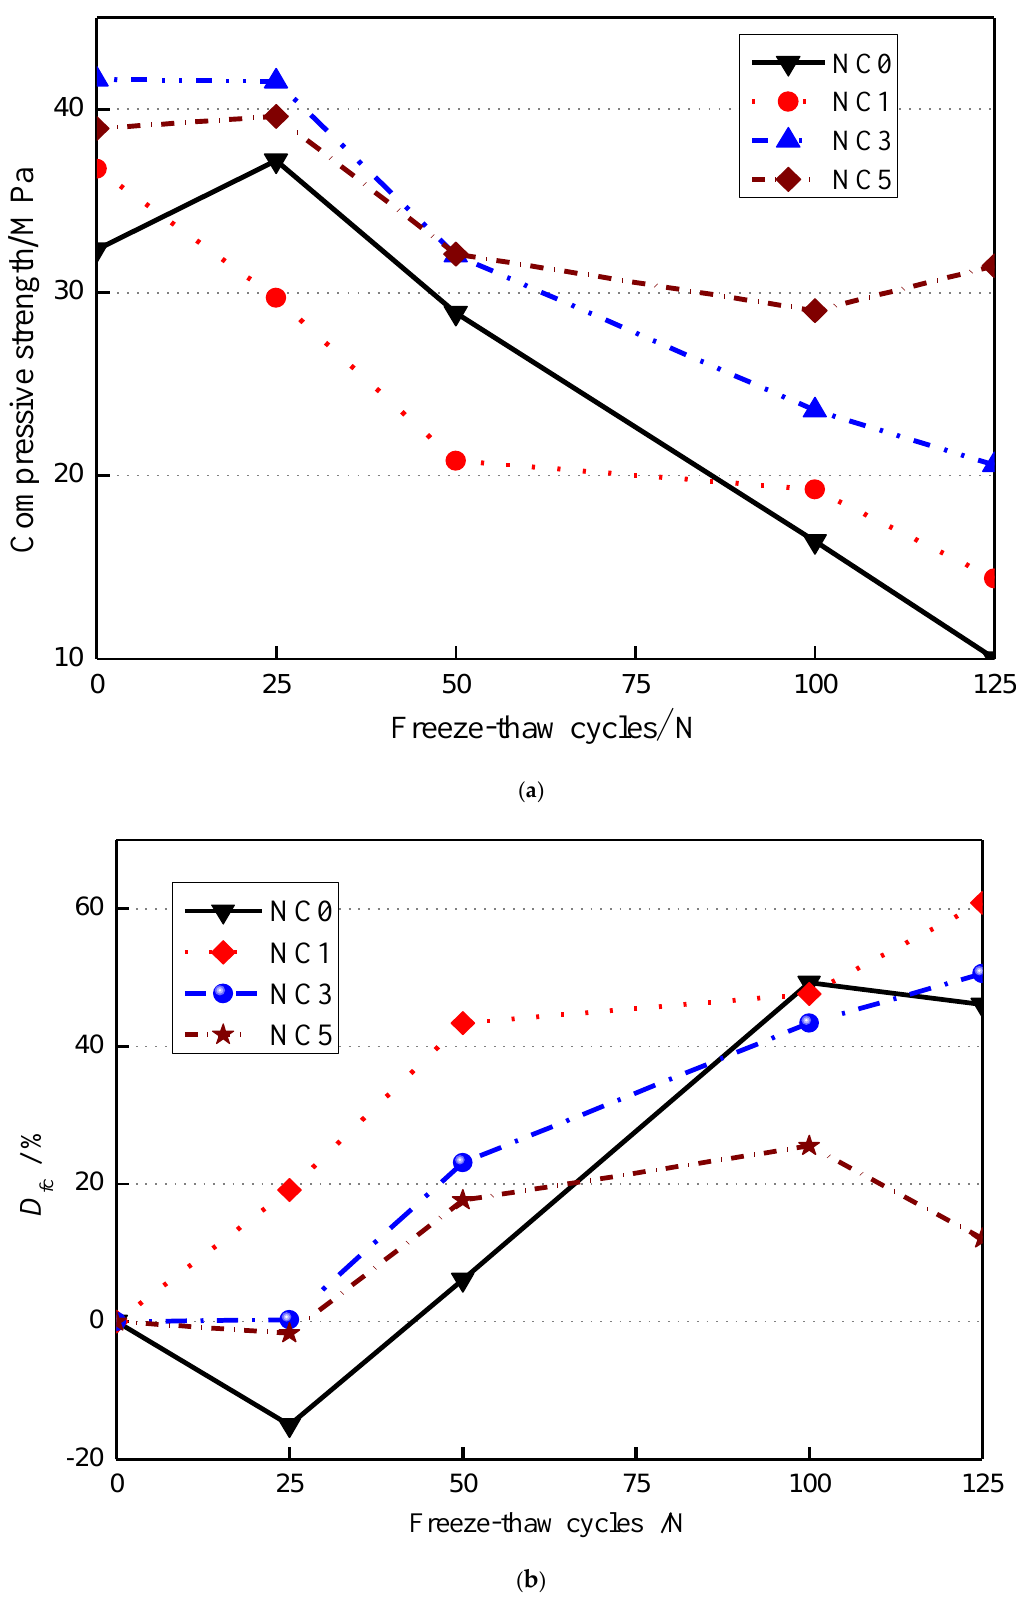
Figure 9. Relationship between compressive strength of NMK added concrete and the number of freeze – thaw cycles. (a) Relationship between compressive strength and freeze – thaw cycles; (b) Relationship between loss rate of compressive strength and freeze – thaw cycles.